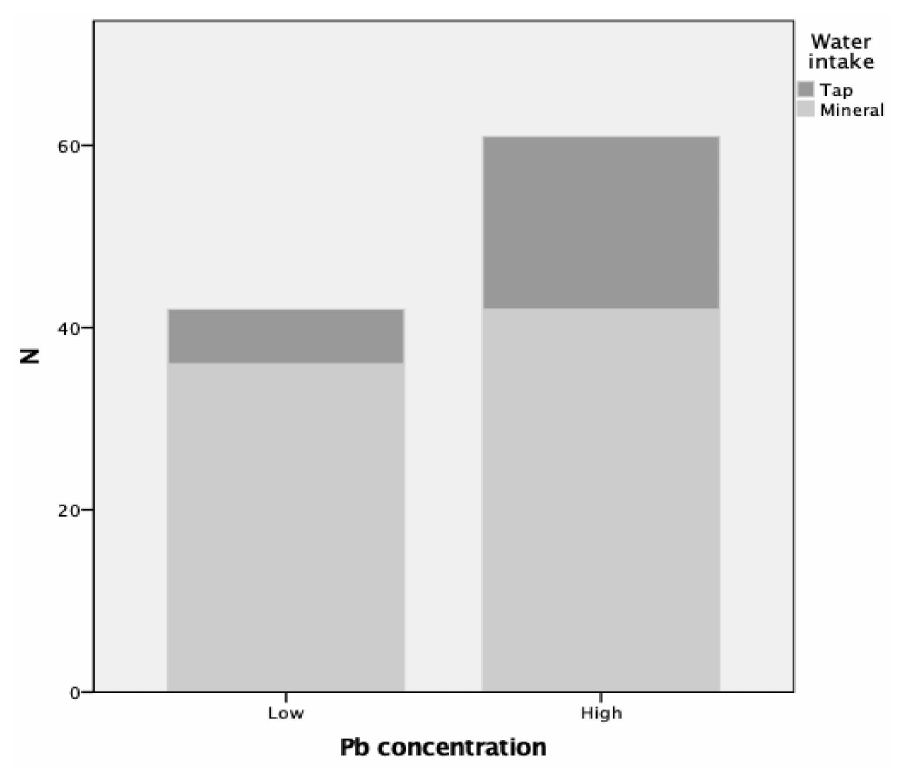
Figure 3. Hg placental concentrations in the female subgroup.